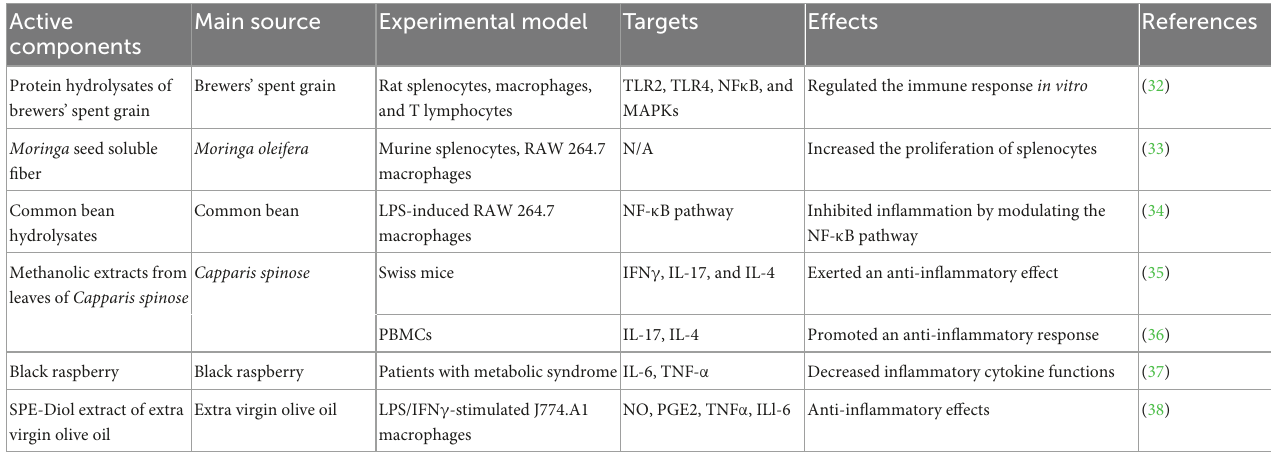
TABLE 1 Anti-inflammatory effects of plant-based functional